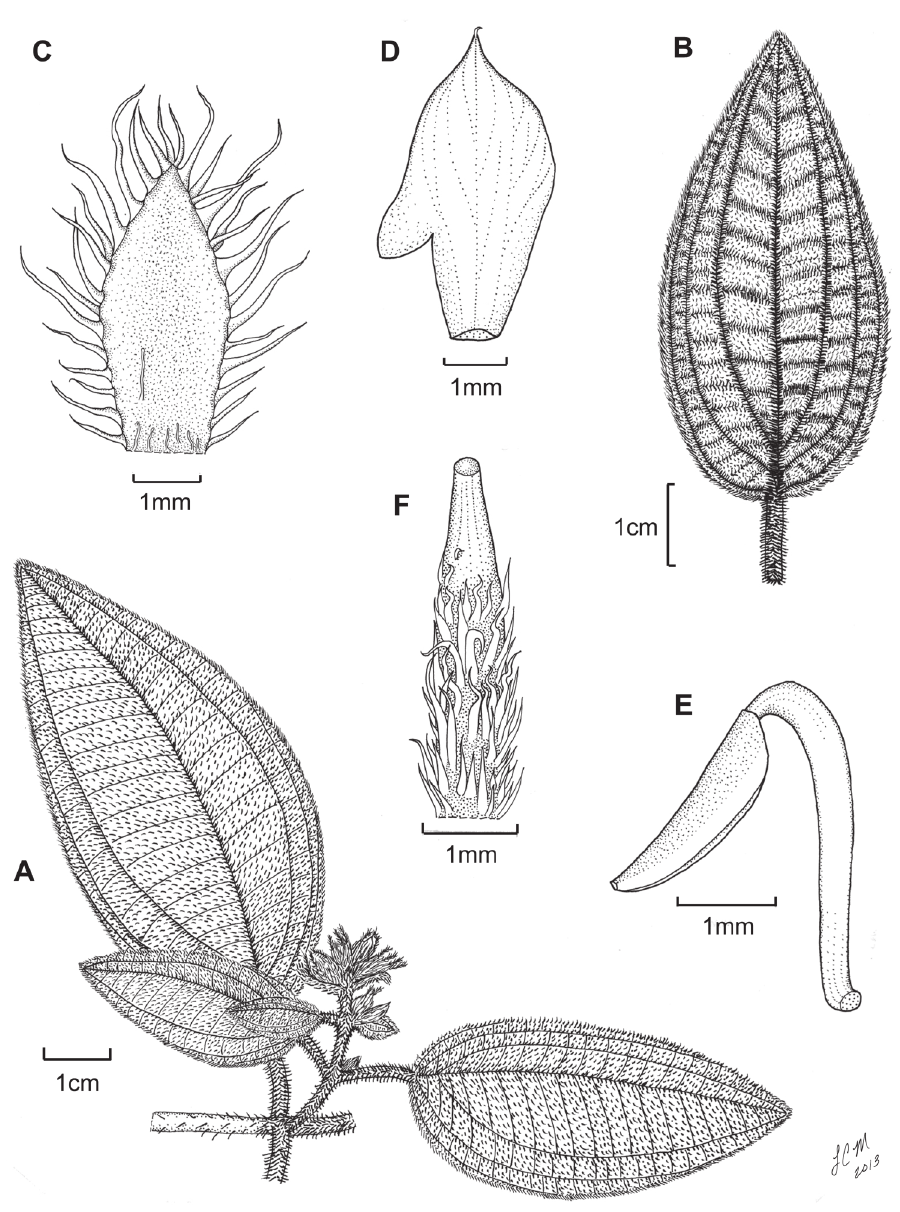
Figure 3. Illustration of Miconia hirtistyla. A habit ( Ekman 14617 ) B leaf abaxial surface ( León LS-10923 ) C bracteole ( León LS-10923 ) D petal ( Ekman 14617 ) e stamen ( Ekman 14617 ) F style ( Ekman 14617 hairs mostly erect to recurved, sessile, glandular, hairs produced along the primary, sec- ondary, tertiary, and quaternary veins between the bulla-based hairs; abaxial leaf surface covered in bulla-based hairs, these mostly erect with undulate apices, those along the